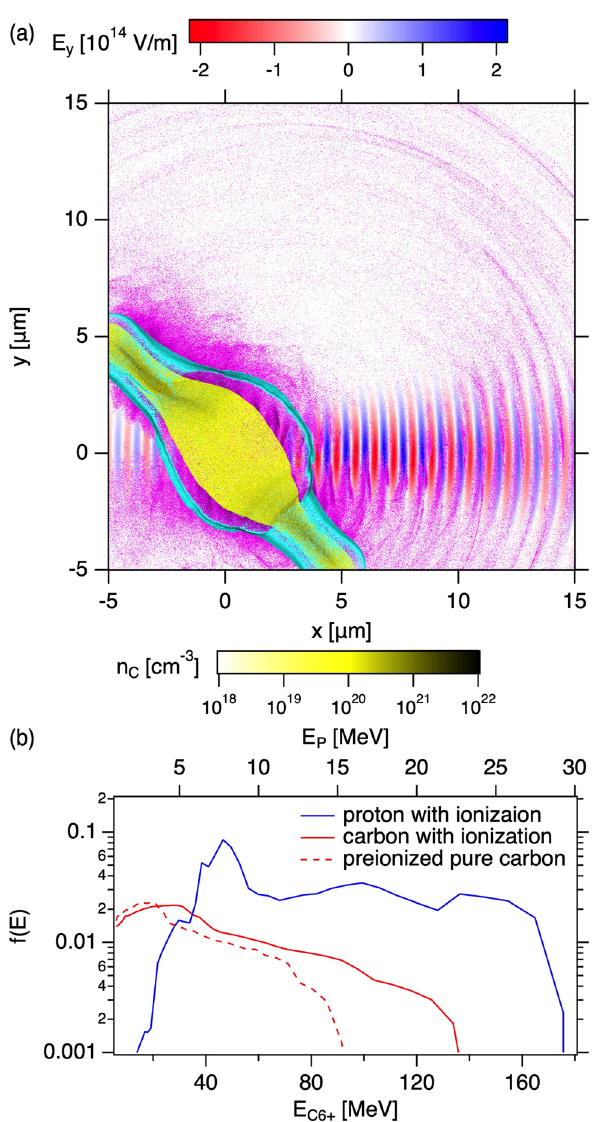
Figure 7. ( a ) The snapshots from 2D Particle-in-cell (PIC) simulation at ∼ 20 fs from the laser peak arrival at the 8 layer LSG target for best focus. The laser electric field E y (blue-red), electron n e (magenta), carbon n C (yellow), and proton number densities n p (cyan) are overlaid. The color scales for the number densities are set to be identical. ( b ) Energy distribution functions calculated from all the protons (blue) and carbons C 6 + (red) in the simulation box of ( a ), normalized as (cid:31) fdE = 1 . The top and bottom axes show the proton and carbon energy, where the top axis is adjusted as 1/6 of carbon energy. The red dashed line represents the pure carbon with